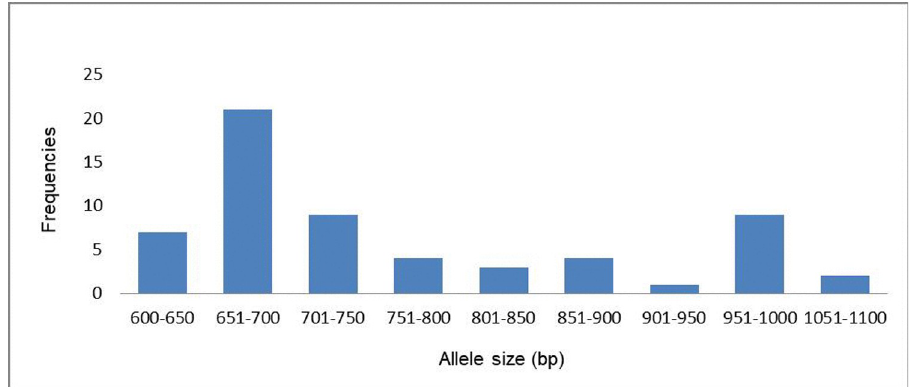
Fig 4. Prevalence of P . falciparum glurp alleles classified by length (base pairs).